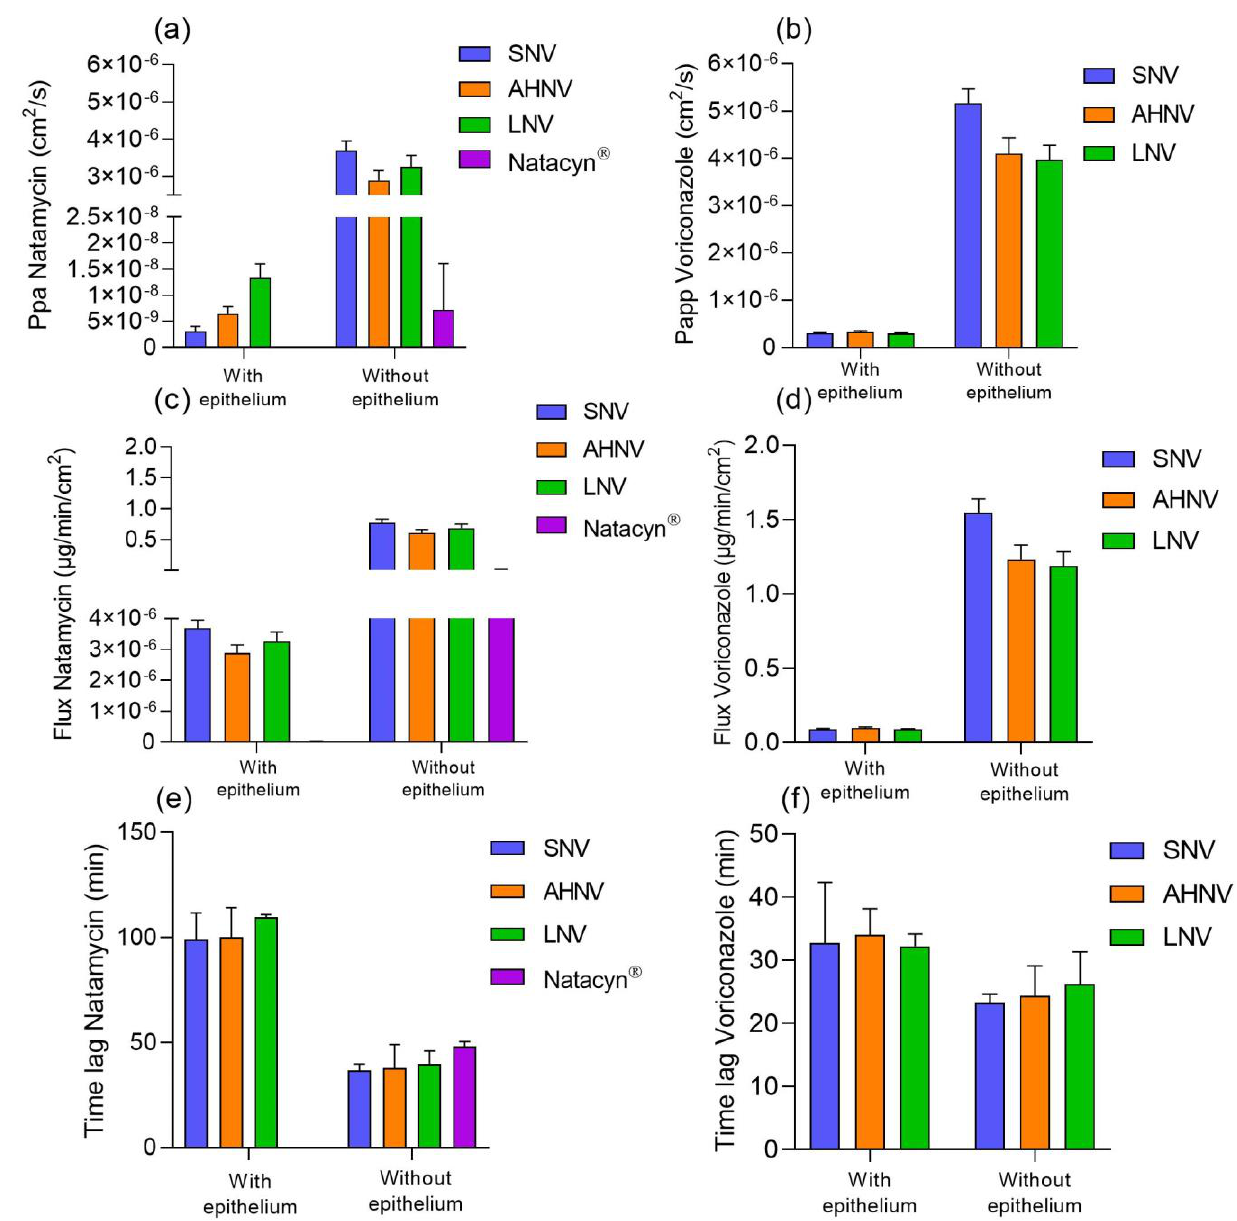
Figure 9. ( a ) Apparent permeability (Papp) of natamycin, ( b ) apparent permeability (Papp) of voriconazole, ( c ) flux of natamycin, ( d ) flux of voriconazole, ( e ) lag time of natamycin, and ( f ) lag time of voriconazole of natamycin and voriconazole formulations across epithelized and deepithe- lized bovine corneas. * Natacyn ® permeability values are not shown because there was no permea- bility of natamycin from this